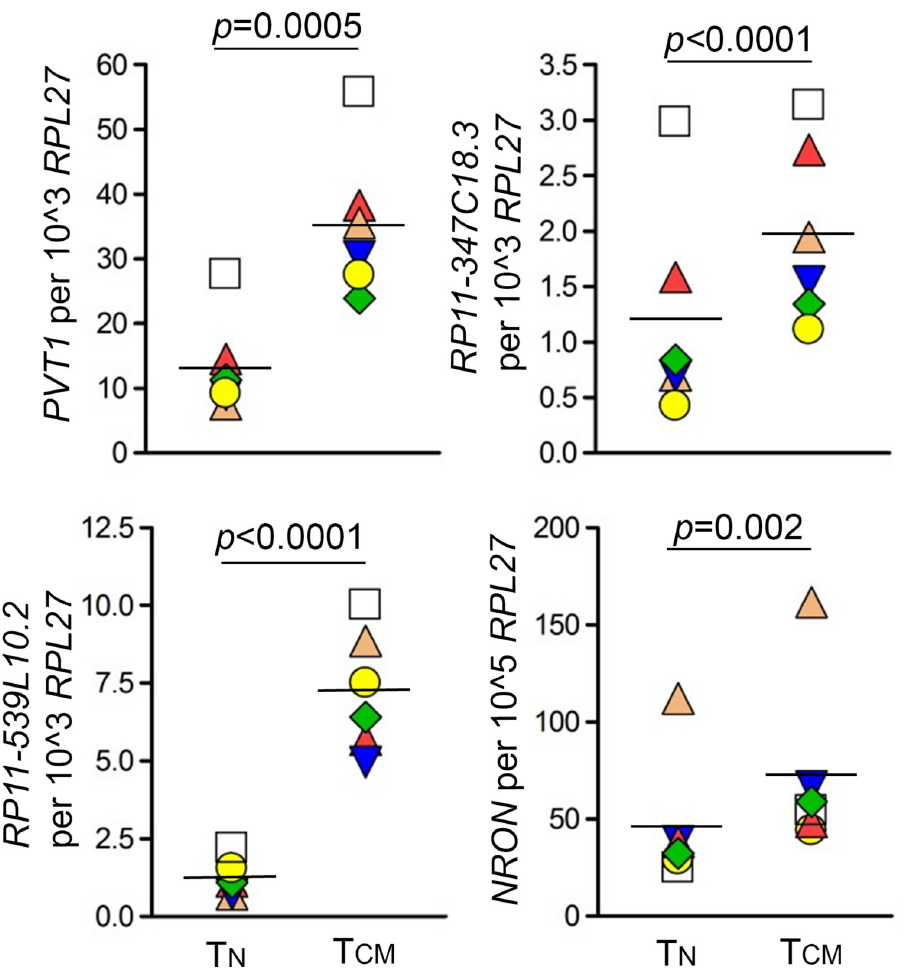
Fig 3. Comparison of lncRNA expression in T N and T CM T-cells. Expression of PVT1 , RP11-347C18 . 3 , RP11- 539L10 . 2 and NRON was measured by ddPCR and normalized to expression of the housekeeping gene RPL27 . Six independent experiments were performed using uninfected CD4+ T-cells. Significance was determined using a paired two-sided t -test for log 2 transformed data. Data is presented as individual data points (copy numbers normalized to RPL27 ) symbol-coded by donor, mean of all values is shown. Samples were generated using blood from donors who were different from those who participated in the study that used models of HIV latency. T N , na ï ve CD4+ T-cells; T CM , central memory CD4+